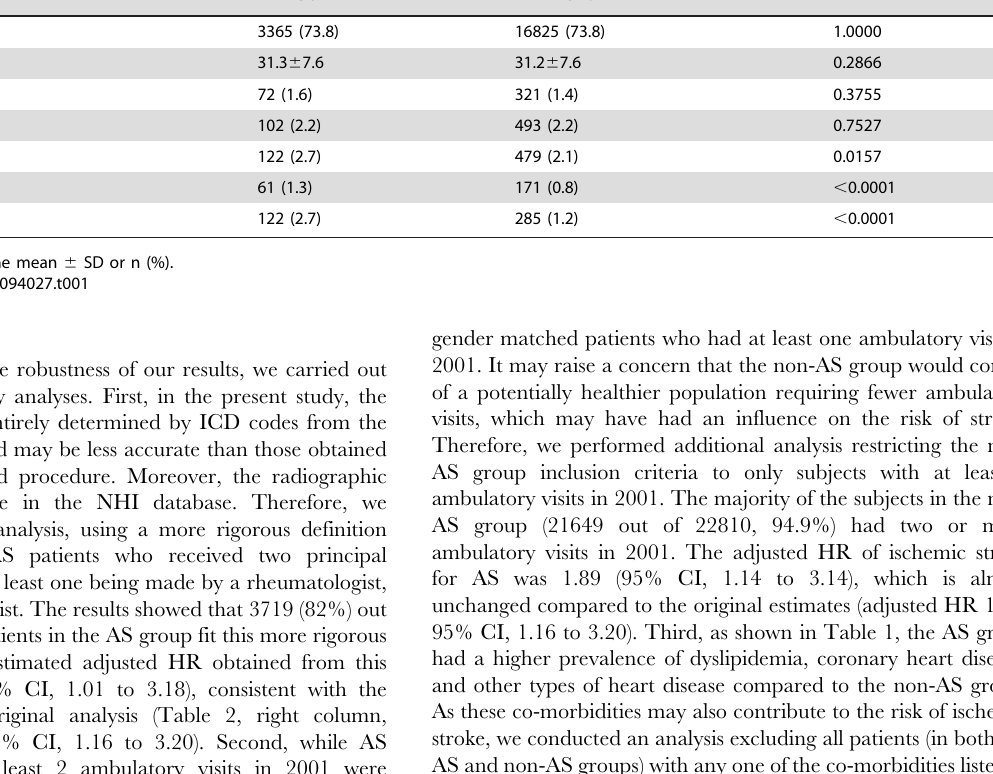
Table 1 (i.e. diabetes mellitus, hypertension, dyslipidemia,